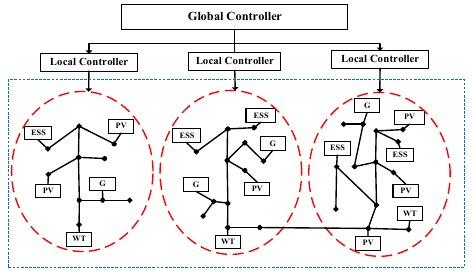
Figure 1. Two-stage controlled distributed energy resources (DER) integrated active distribution network (ADN) model.